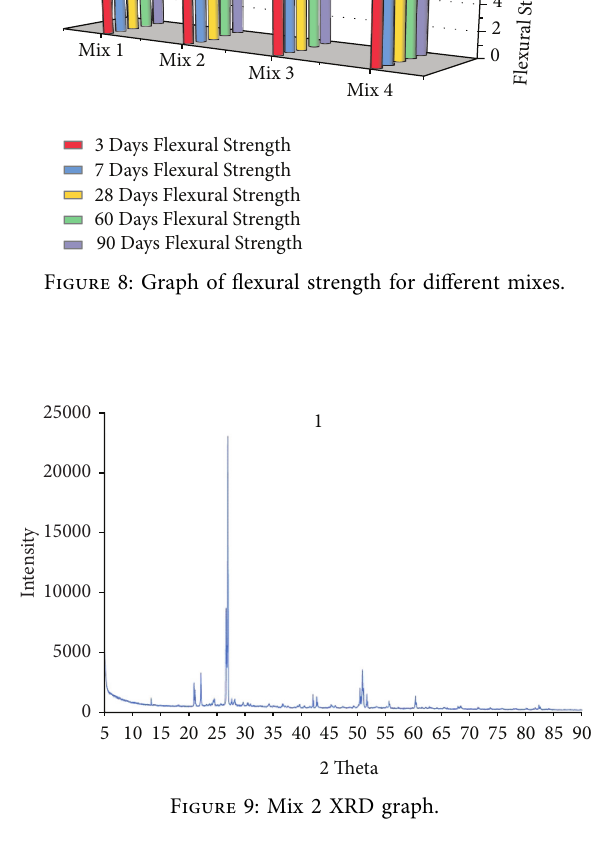
Figure 6: Graph of compressive strength for different mixes.